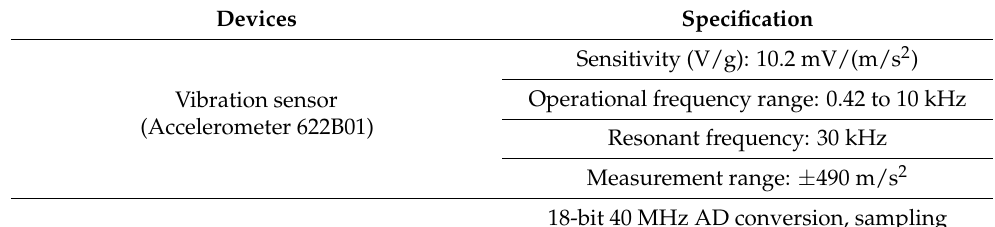
Table 1. The specifications of the sensors and the acquisition module.